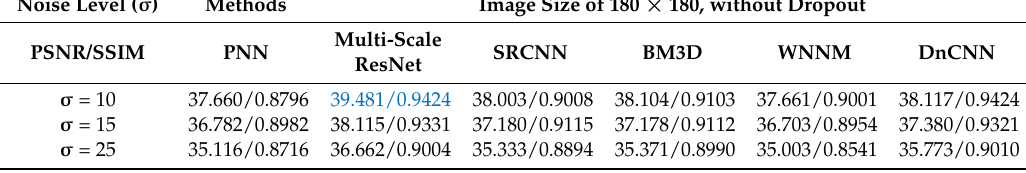
Table 7. The average results of our aerial-image model, where the multi-scale residual learning network (ResNet) was the proposed aerial-image denoising method in the paper. The corresponding experimental parameters were x = 5, y = 3, scaling parameter z = 4, and network depth of 26 (blue font indicates the